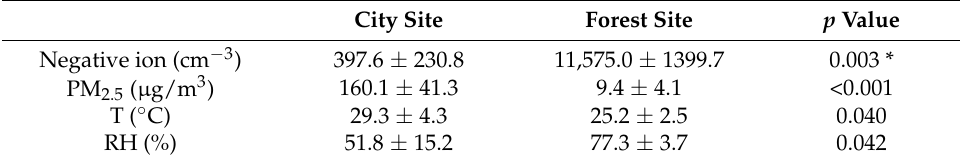
Table 2. Quantitative detection of air quality in the two experimental sites (mean ± SD).